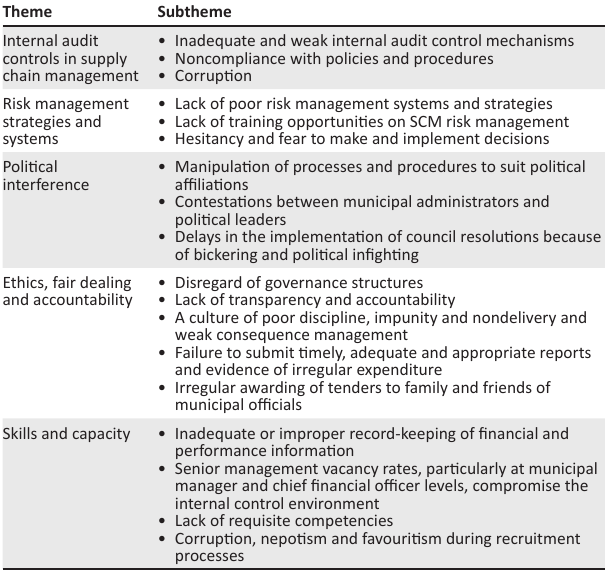
TABLE 2: Schematic representation of themes and